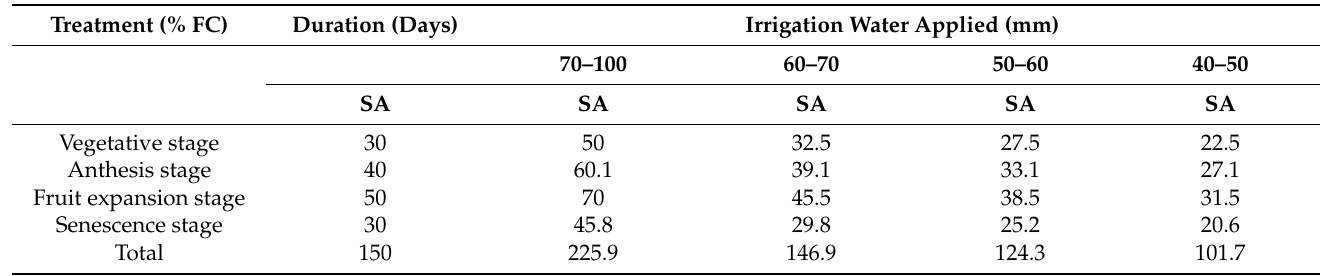
Table 5. Irrigation water applied for tomatoes throughout the growing cycle for each growth stage for the different treatments in sandy loam soil (SA).